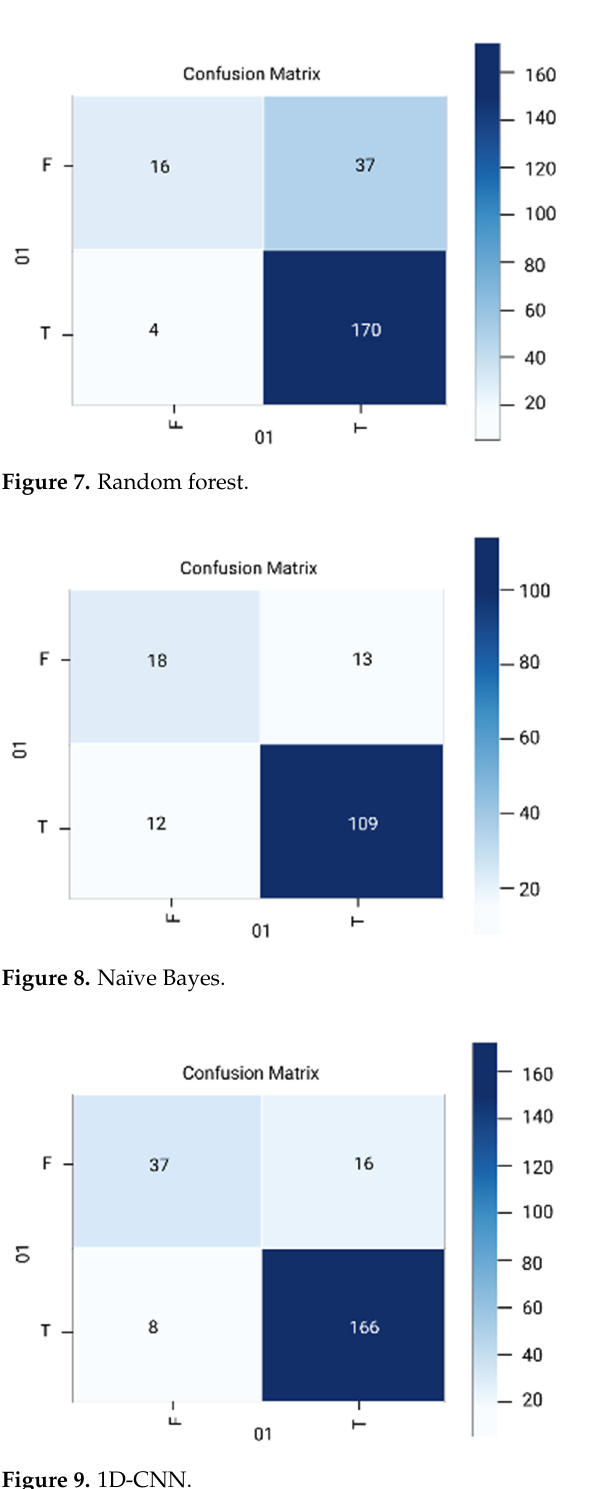
Figure 6. Support vector machine.